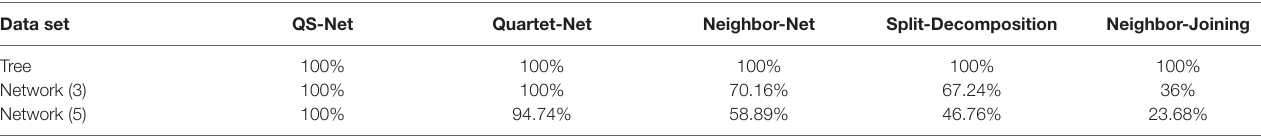
TABLE 1 | Comparison of accuracy (the total bootstrap value obtained from the experimental results is divided by the bootstrap BV value) between QS-Net and four other methods. Data set